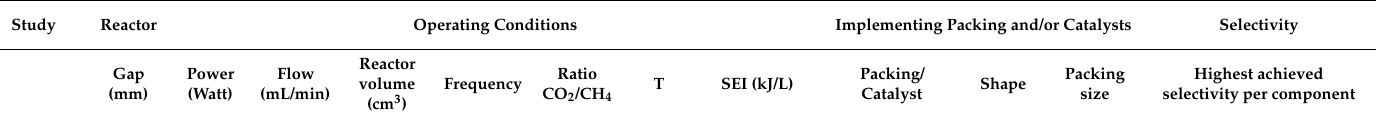
Table 1. Summary of a selection of literature for CO 2 splitting in a non-packed and a packed DBD reactor.